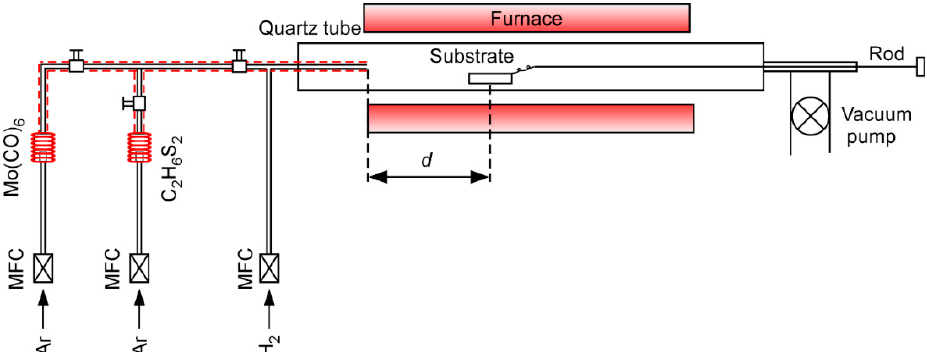
Figure 1. Schematic illustration of chemical vapor deposition (CVD) system.